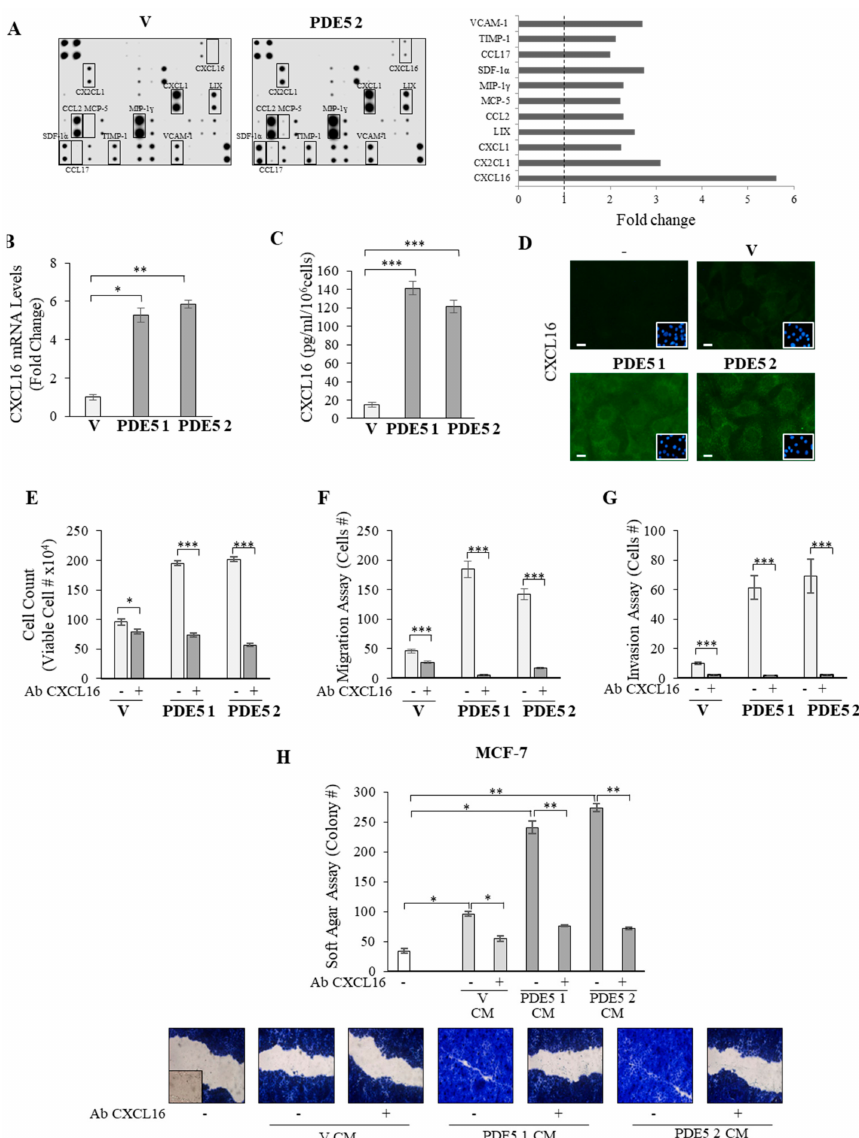
Figure 5. Role for C-X-C motif chemokine 16 (CXCL16) in mediating tumor-promoting features of PDE5-overexpressing fibroblasts. ( A ) Mouse cytokine arrays for the detection of secreted proteins in conditioned medium derived from vector (V) and PDE5-overexpressing (PDE5 2) MEFs. Left panels: membranes, 62 targets detected. Right panels: raw numerical densitometry data were extracted, the background subtracted, and the data normalized to the positive control signals. Results are shown as fold change of PDE5 2 versus V stable clones. ( B ) Real-time RT-PCR assay for CXCL16 mRNA expression in V, PDE5 1, and PDE5 2 stable clones. ( C ) ELISA for CXCL16 protein secretion in V, PDE5 1, and PDE5 2 stable clones. ( D ) Immunofluorescent staining of CXCL16 protein expression in V, PDE5 1, and PDE5 2 stable clones. DAPI staining was used for nuclei detection (inset). Scale bar = 5 µ m. ( E ) Trypan blue cell count assays in V, PDE5 1, and PDE5 2 stable clones treated with vehicle (-) or CXCL16 blocking antibody (Ab CXCL16, 1.5 µ g / mL) for 72 h. ( F ) Boyden chamber transmigration and ( G ) invasion assays in cells treated with vehicle (-) or Ab CXCL16. ( H ) Soft agar growth (upper panel) and wound healing (lower panel) assays in MCF-7 breast cancer cells exposed with conditioned medium (CM) derived from V, PDE5 1, and PDE5 2 stable MEFs treated with vehicle (-) or Ab CXCL16. Inset, time 0. Pictures are representative of three independent experiments. The values represent the mean ± SEM of three di ff erent experiments, each performed in triplicate. * p < 0.05; ** p < 0.005; *** p <